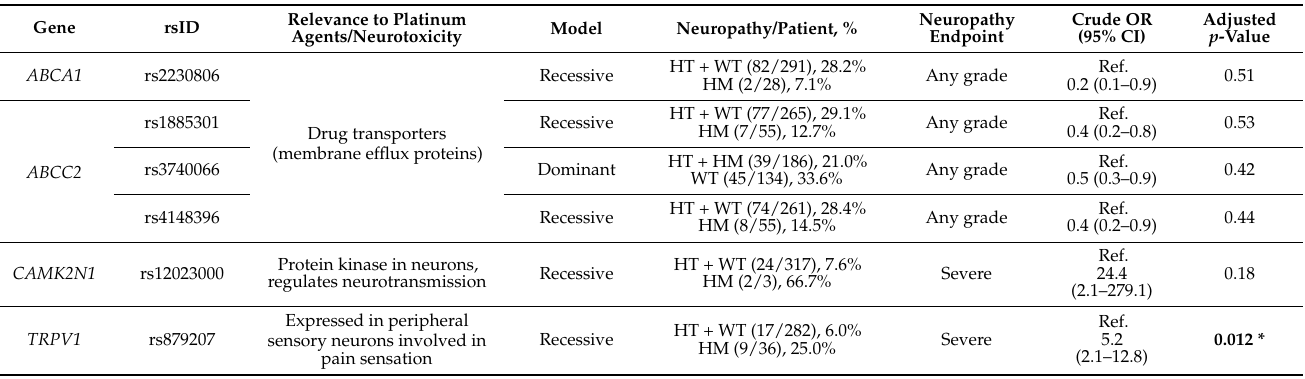
Table 2. Associations of SNPs with